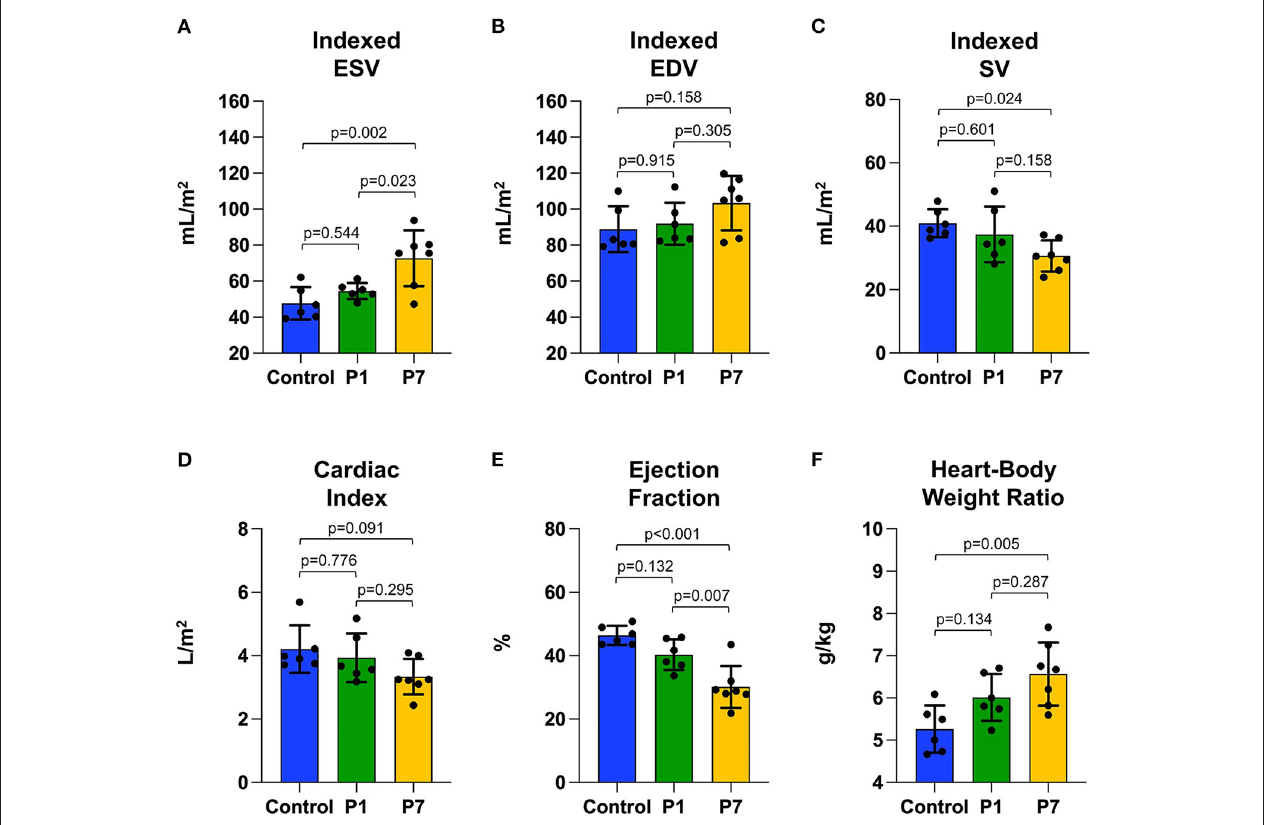
FIGURE 2 | Piglets naturally recover left ventricular function after myocardial infarction on postnatal day 1. At 7 weeks after myocardial infarction (MI), cardiac magnetic resonance imaging was performed to evaluate left ventricular function, including (A) end-systolic volume (ESV) indexed against body surface area, (B) end-diastolic volume (EDV) indexed against body surface area, (C) stroke volume (SV) indexed against body surface area, (D) cardiac index, and (E) ejection fraction. Following heart explant, the (F) heart weight to body weight ratio was determined. No significant differences were observed between pigs receiving MI on postnatal day 1 (P1) compared to healthy controls. Pigs receiving MI on postnatal day 7 (P7), however, developed left ventricular